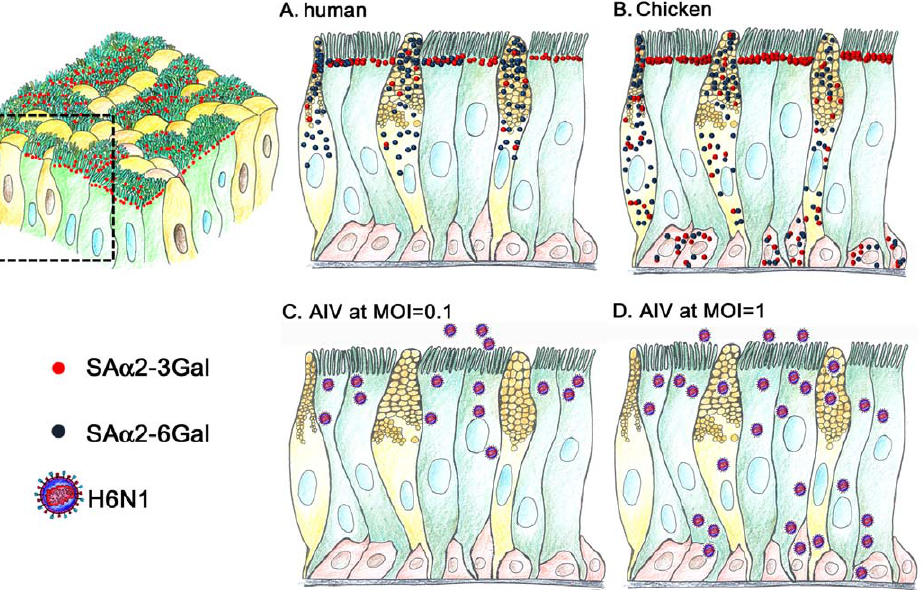
Figure 6. A speculated diagram of the SA expression and AIV infection in human and chicken tracheal epithelial cells. The structure of the pseudostratified tracheal epithelial cells (A) and the human (A) and chicken (B) expression profiles of SA a 2–3Gal (red dots) and SA a 2–6Gal (blue dots) on the ciliated cells (green), goblet cells (yellow) and basal cells (pink) are illustrated. Infection of chicken tracheal epithelial cells by AIV at a MOI of 0.1and 1 are illustrated in C and D, respectively.